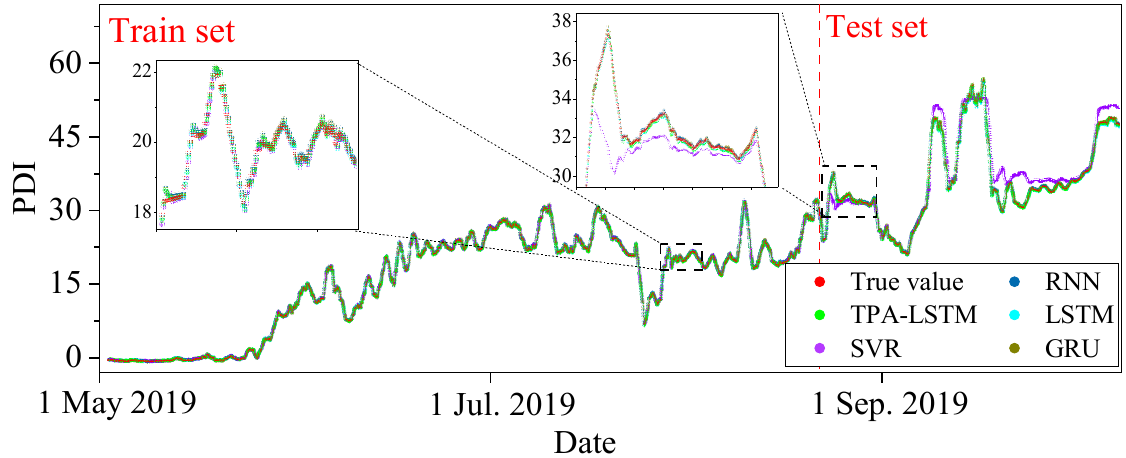
Figure 21. Prediction results of the compared models.